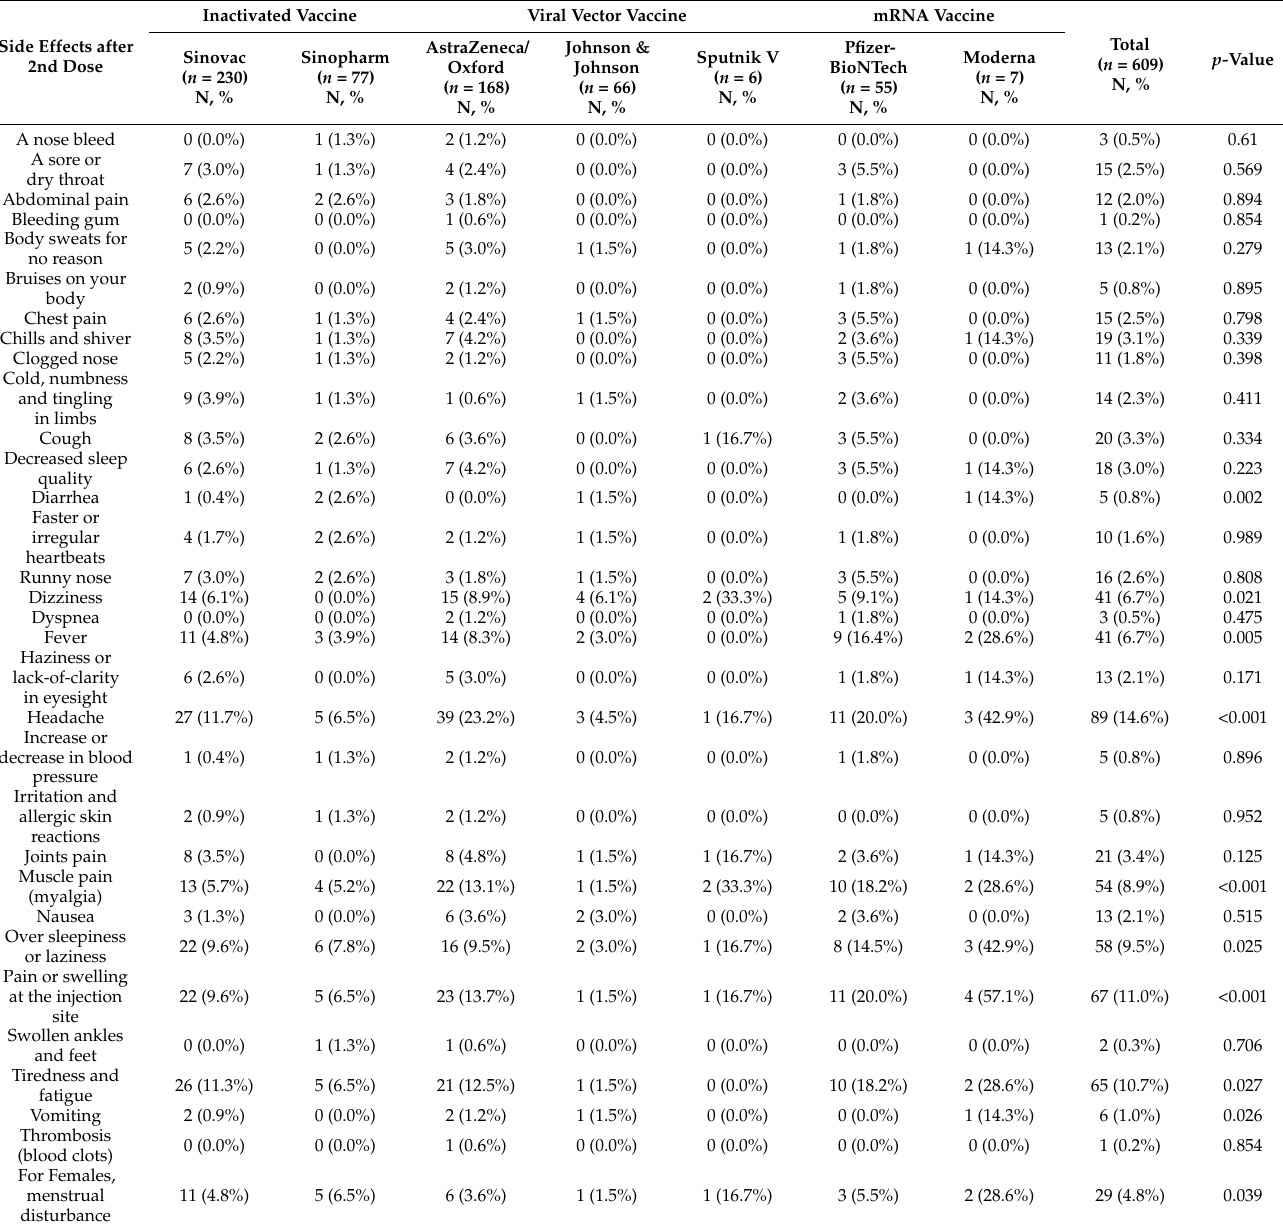
Table 4. COVID-19 vaccine side effects reported by the participants after the second dose of different vaccine types ( n =